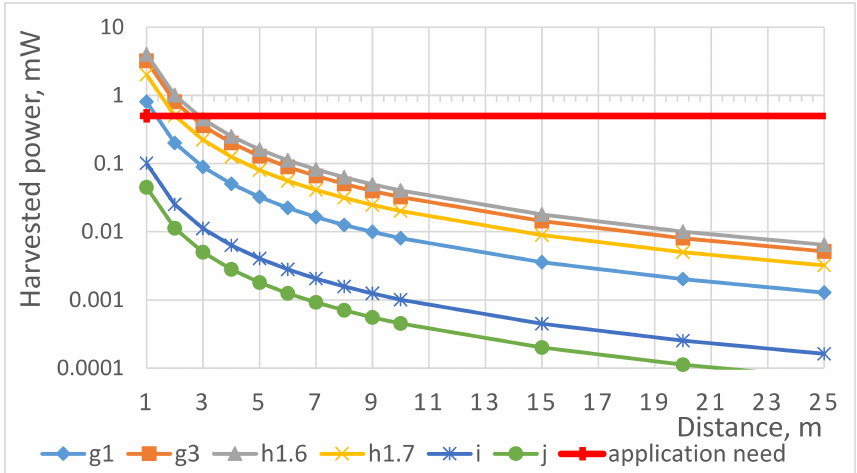
Figure 2. Maximum power transferred via wireless power transfer in different Industrial, Scientific and Medical bands (assuming use of dipole antennas and 50% radio frequency-direct current conversion